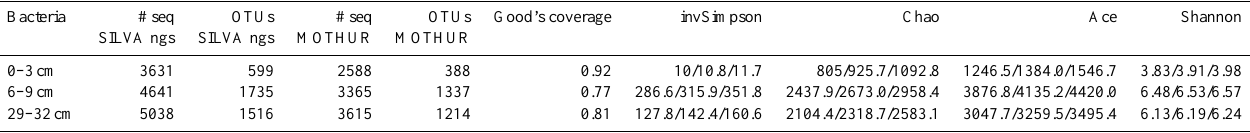
Table 1. Bacterial sequences used for classification in SILVA ngs and for subsample in MOTHUR for the alpha diversity. Bacteria